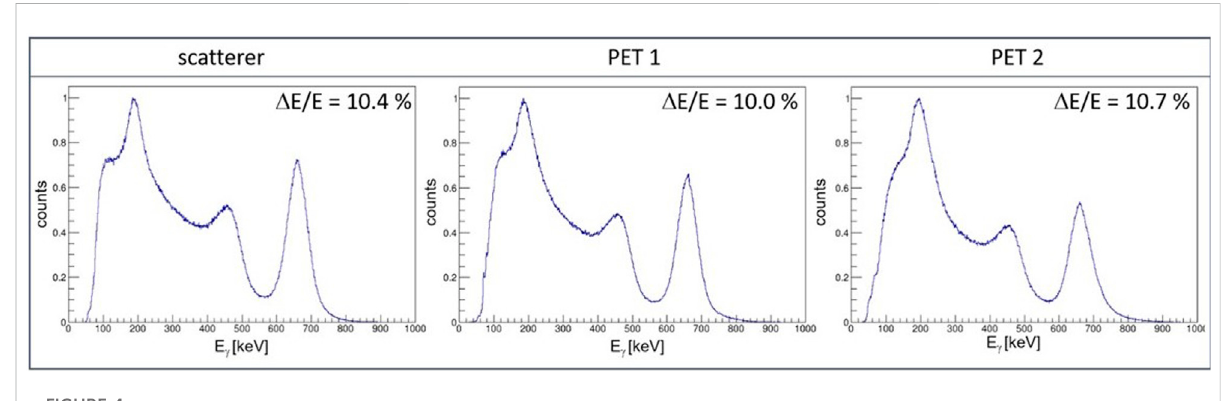
FIGURE 4 Inclusive energy spectrum of all 256 individual crystals obtained from a 137 Cs point source acquired using the scatter (left), PET detector 1 (center) and PET detector 2